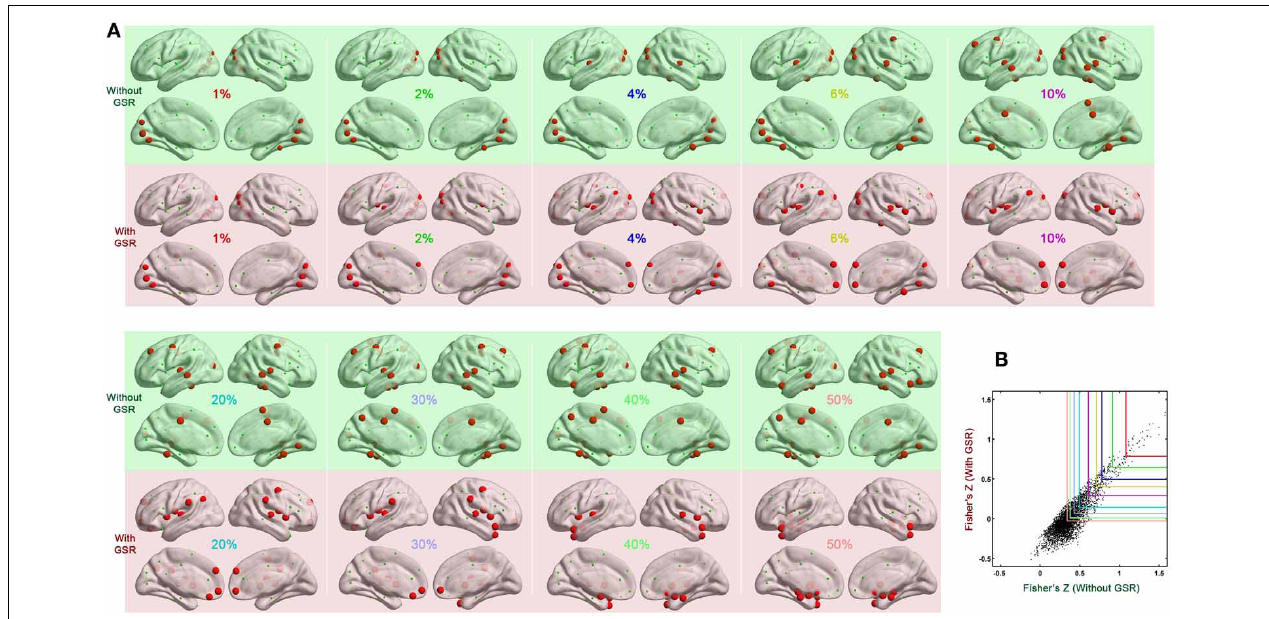
FIGURE 3 | Impact of density on hub distribution. (A) Hub distribution across various densities either without GSR (green shaded) or with GSR (pink shaded) derived from the data corrected with Friston 24 model. With stringent density thresholds, the hub distributions are similar between data with and without GSR. When the density increases, the discrepancy of hub